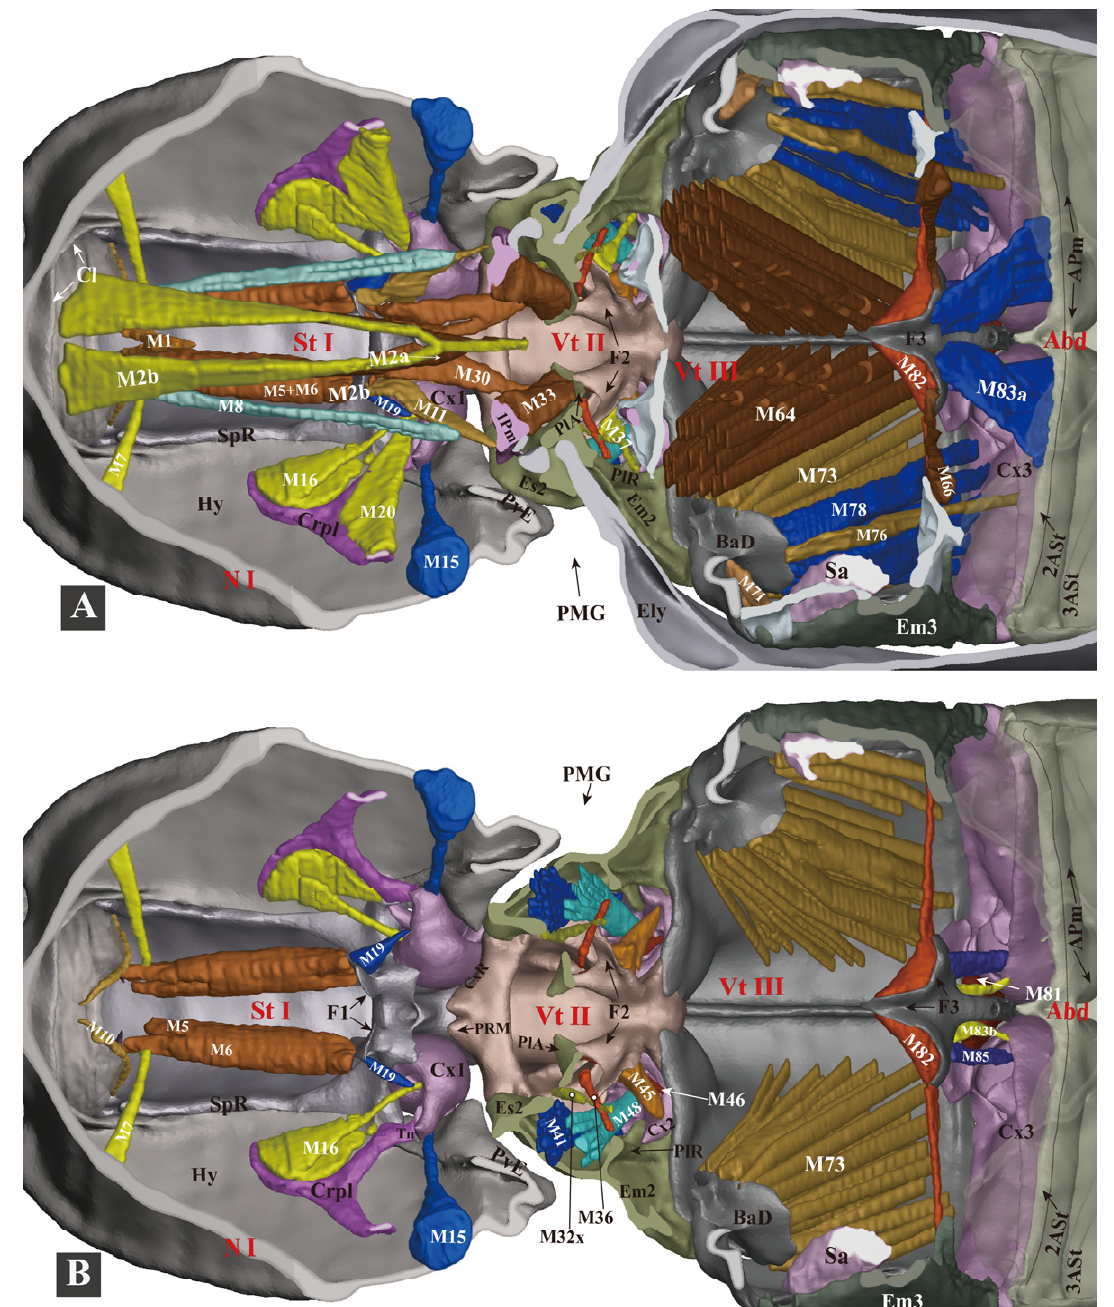
Figure 10. Three-dimensional reconstructions of the thoracic skeleton and musculature of Campsoster- nus auratus , dorsal view, part 2. The head of the model is facing left, and the model is cut in the frontal (coronal) plane at different layers ( A , B ) to show internal musculature; for technical information and abbreviations, see Section 2 ‘Materials and Methods’. Some of the muscles are removed to show the ones hidden